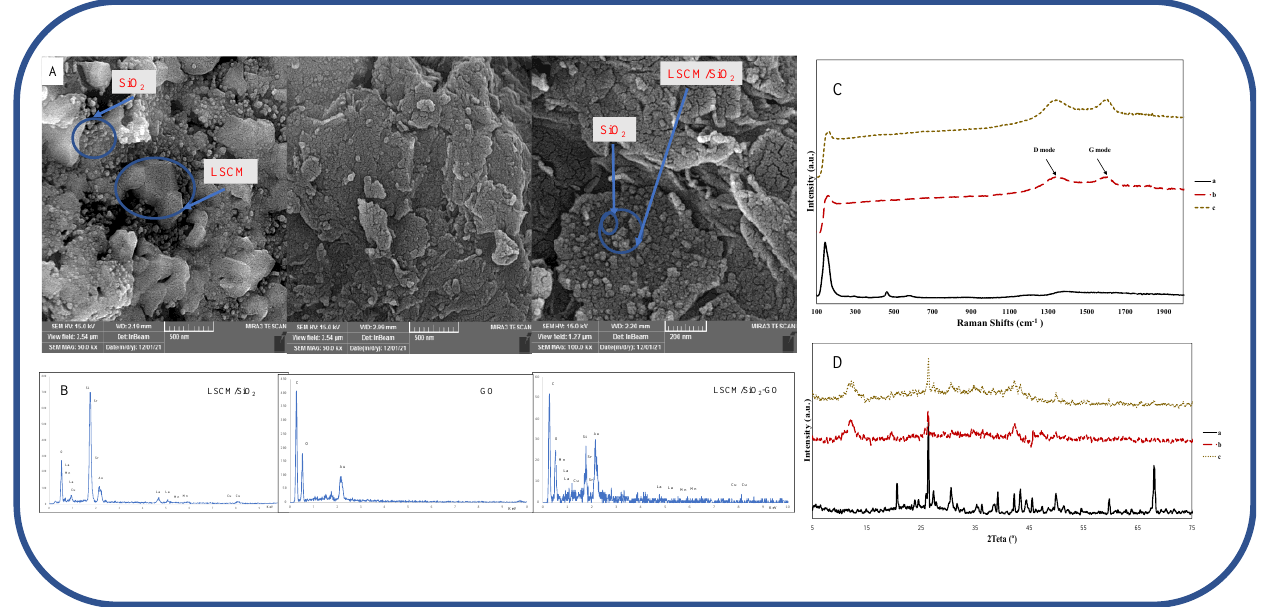
Figure 2. ( A ) SEM and ( B ) EDS results of LSCMO-S, GO, and LSCM-S/GO, ( C ) Raman spectra of LSCMO-S (a), GO (b), LSCMO-S/G (c), ( D ) XRD results of LSCMO-S (a), GO (b), and LSCMO-S/GO (c).